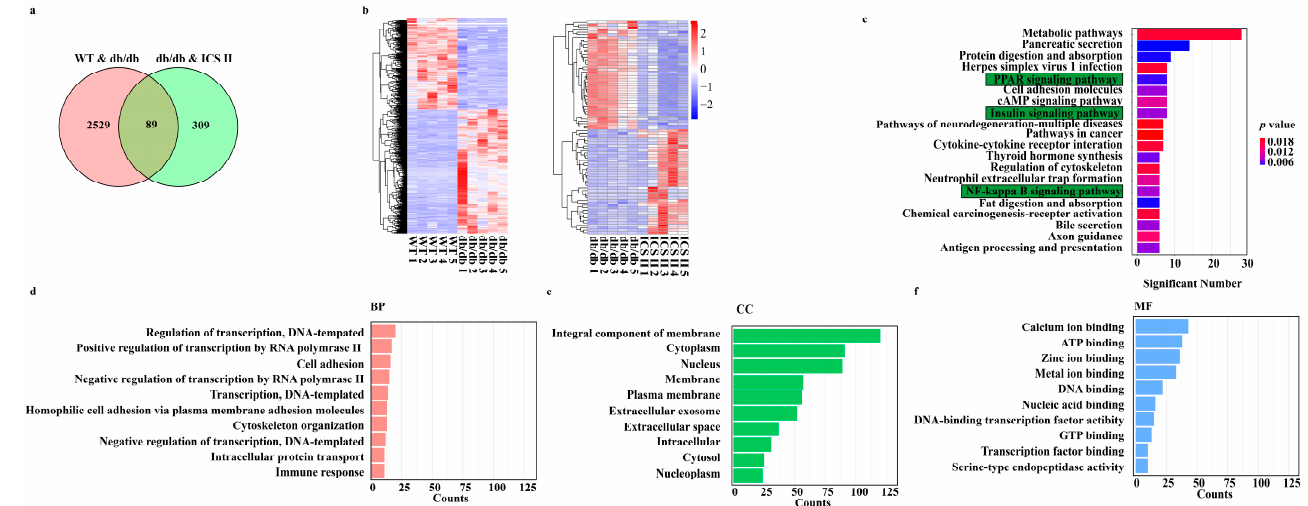
Figure 3. Analysis of DEGs profiling of the liver in mice. ( a ) The DEGs between WT versus db/db groups and ICS II versus db/db groups were summarized in a Venn diagram. ( b ) The correlation coefficients between altered gene expression profiles were analyzed using hierarchical clustering analysis. ( c ) Top KEGG pathways enriched with DEGs and their matching P values. ( d – f ) Bar graph shows the fold enrichment values of the top 10 most significantly enriched terms for the regulation of genes, analyzed by GO terms.